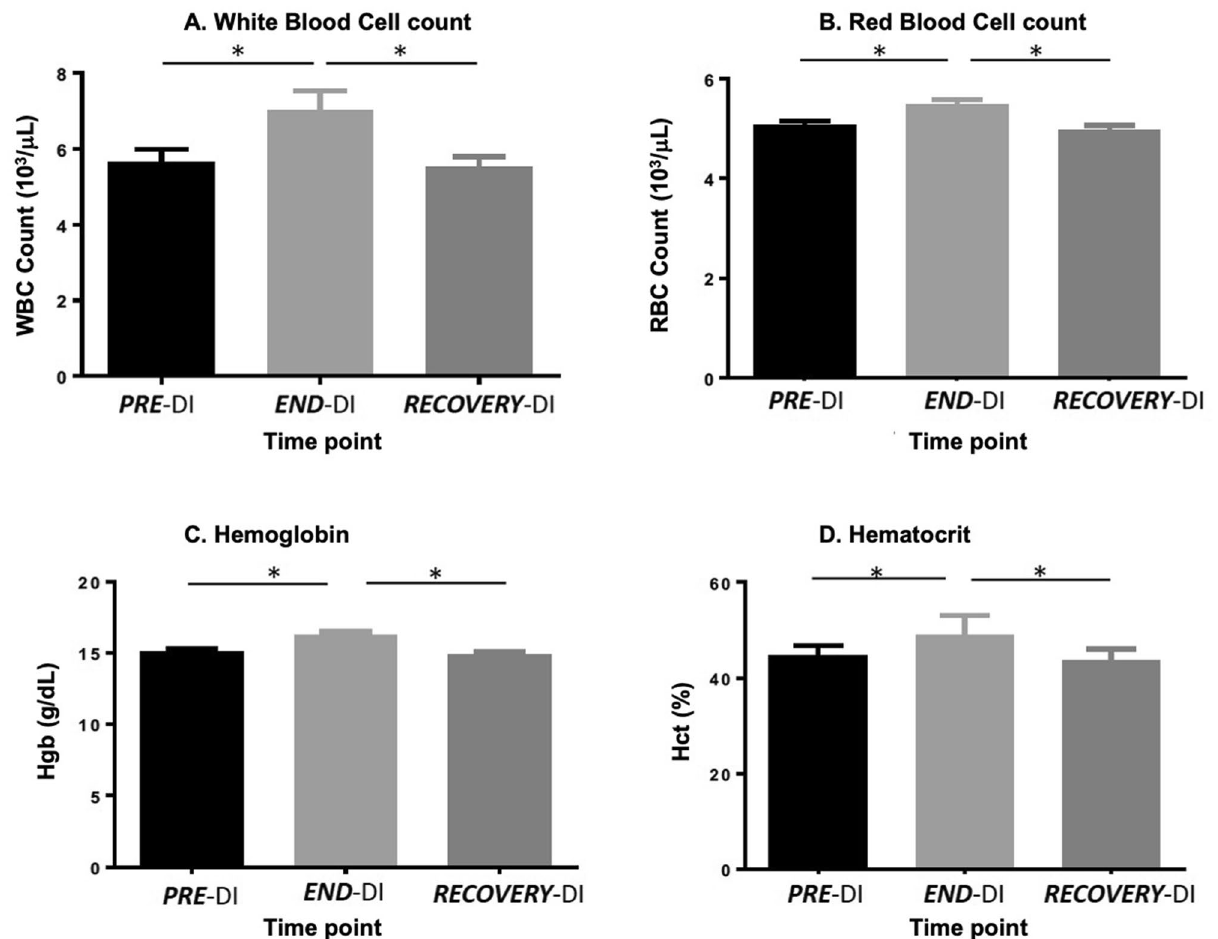
Figure 1. Effect of dry immersion and physical inactivity on RBC and WBC characteristics. Graphs represent the mean ± SEM of each parameter at each time point. ( A ) White Blood Cell count, ( B ) Red Blood Cell count, ( C ) Haemoglobin and ( D ) Haematocrit. *P < 0.05. Paired samples t-test and repeated measures ANOVA (adjusted for age, BMI and VO 2; n = 12, biological